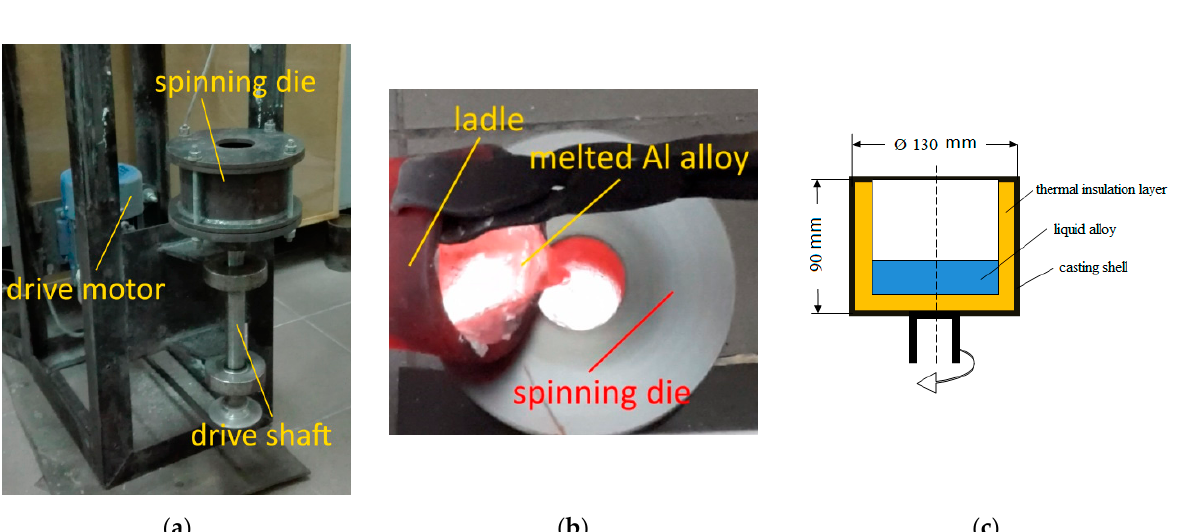
Figure 1. Centrifugal casting installation, with vertical rotation axis. ( a ) Experimental device, ( b ) casting process, ( c ) casting shell design.